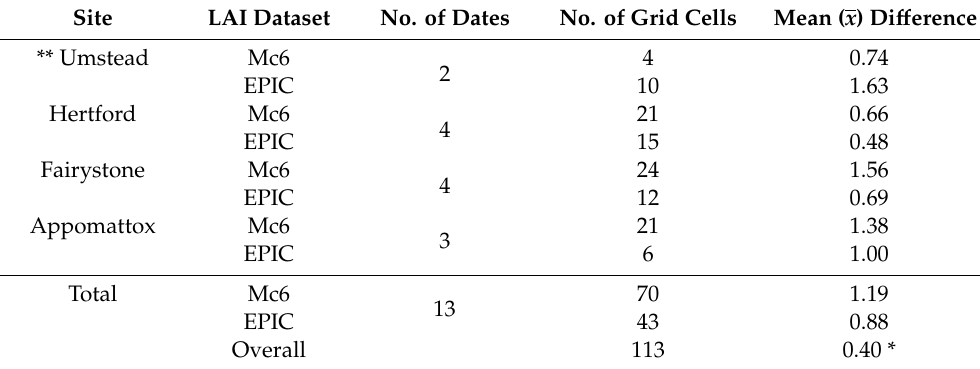
Table 11. 12.0 km grid-based mean differences per LAI site over all EPIC and Mc6 LAI data collections